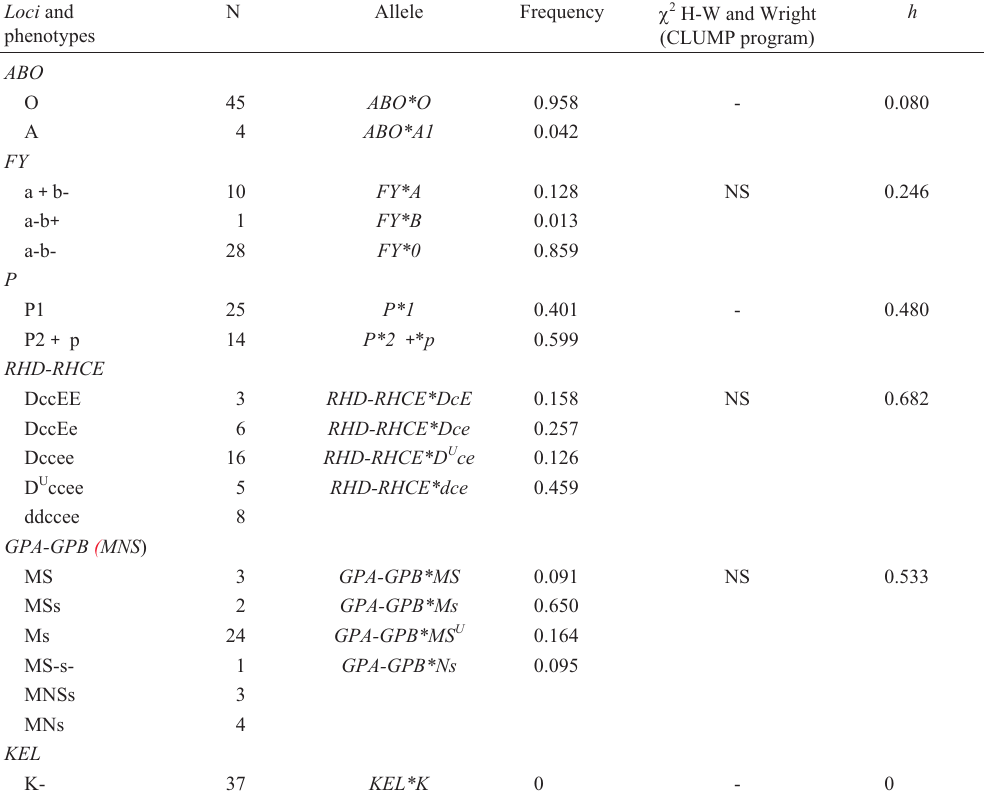
Table 1 - Phenotype distribution, gene frequencies and heterozygozity ( h ) for 14 loci investigated in Valongo. See text for loci and phenotype abbreviation key. Loci and phenotypes